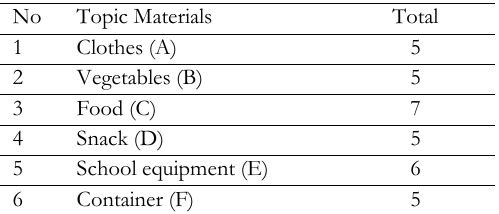
TABLE 1. The specification of the test items